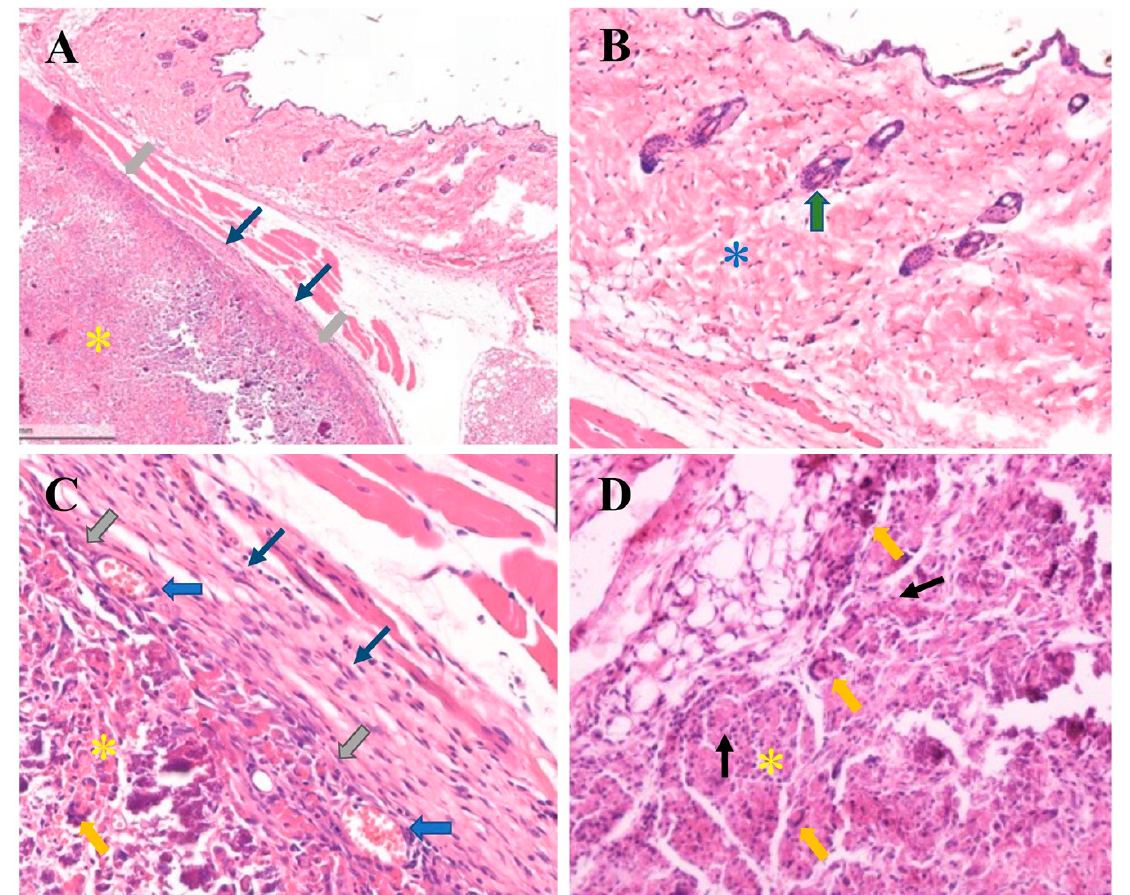
Figure 11. Histological images of the subcutaneous implants of a hydrogel group; the thermosensitive 2% ( w / v ) calcium carbonate microcapsule–2% nanohydroxyapatite–10% β -glycerophosphate–4:1 ( w / w ) chitosan/collagen hydrogels were subcutaneously implanted in C57BL/6NJcl mice for 4 weeks ( A – D ). ( A ) Spatial implant/tissue interface exhibiting that the sample is separated from the host tissue by thin layers of fibrous connective tissue (thin blue arrows), and thick grey arrows indicate inter-surface contact between the subcutaneous tissue and a residual implant or hydrogel (yellow asterisks). ( B ) A high magnification of mouse skin comprises dense fibrous connective tissue (blue asterisk), the hair follicle (thick green arrow), and keratinized epithelium. ( C ) A high magnification of a sample/tissue interface exhibiting multiple layers of connective tissue (thin blue arrows), direct contact of the sample, and the connective tissue layers (thick grey arrows) with infiltration of small blood vessels at the interface (thick blue arrows). ( D ) Exhibiting the residual implant or hydrogel (yellow asterisk), and low numbers of lymphocytes infiltration (chronic inflammatory cells) (thin black arrows) and multinucleated giant cells (thick yellow arrows) (hematoxylin and eosin, H&E stain), ( A ) magnification 10×; ( B – D ) 40×).